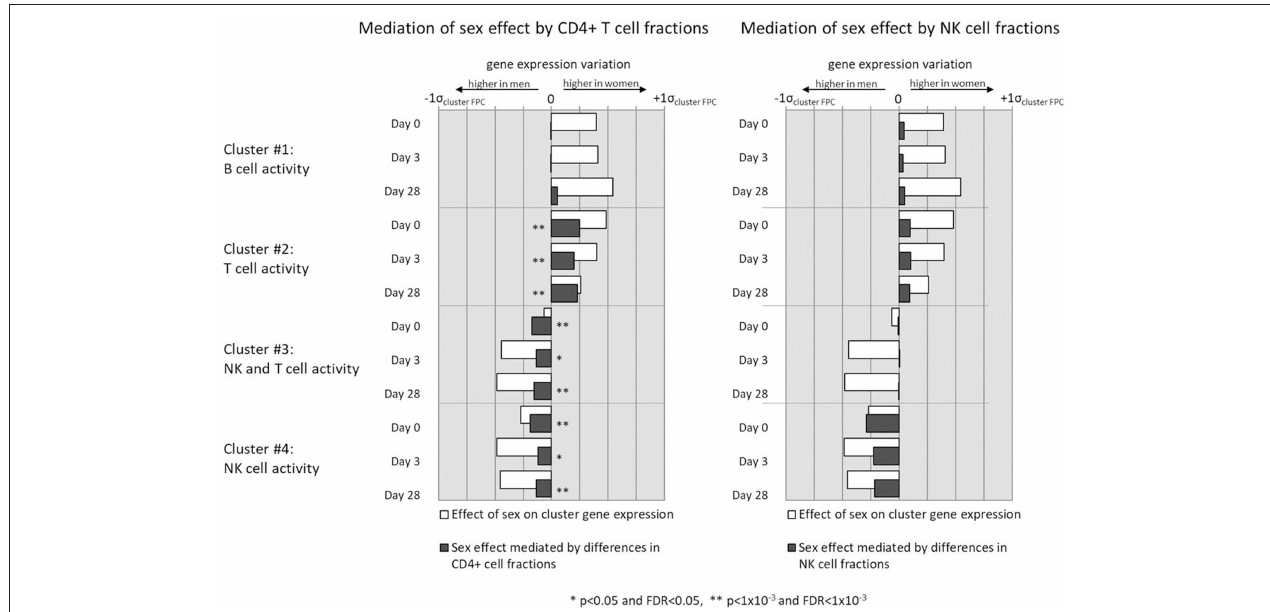
FIGURE 5 | Mediation analysis indicates whether sex-related differences in gene expression of select gene clusters is mediated by observed sex differences in CD4 + cell (left column) and NK cell (right column) fractions of subject PBMCs.